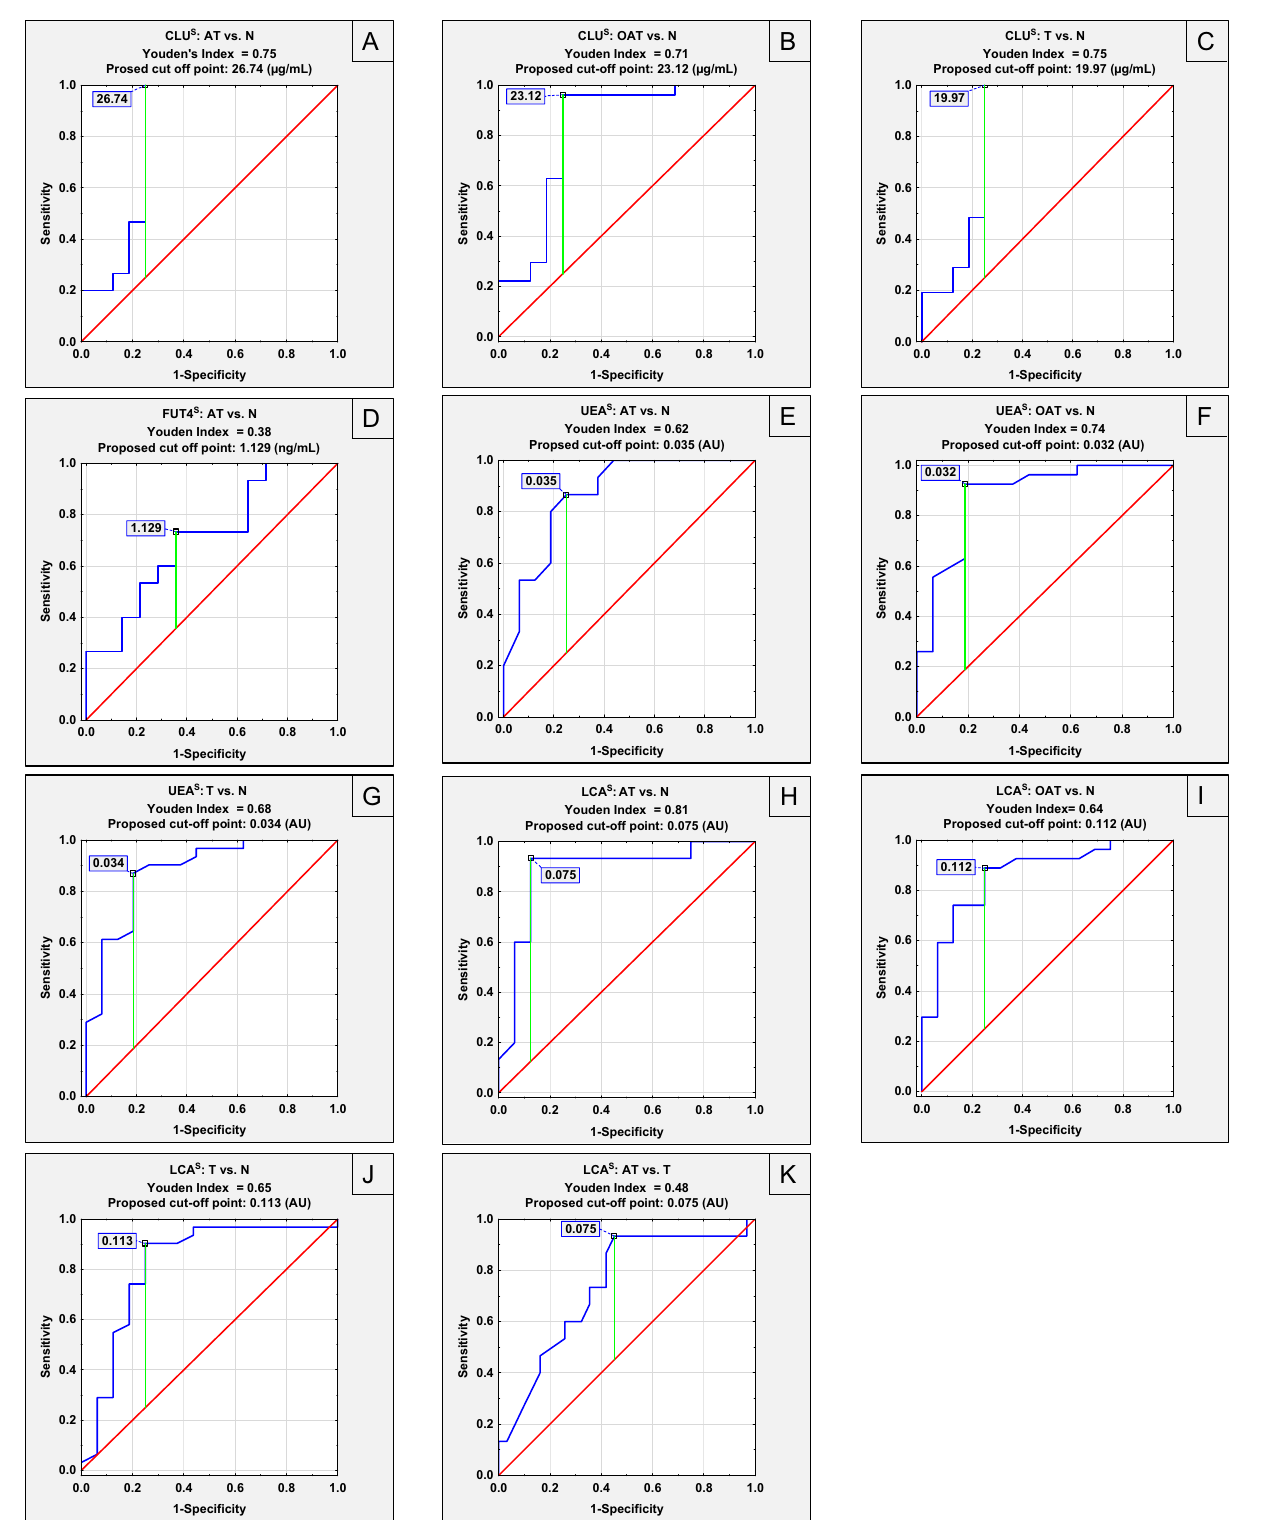
Figure 4. Receiver operating characteristic (ROC) curves for serum parameters with the area under the curve (AUC) more than 0.700 ( A–K ). CLU S —serum CLU concentration; FUT4 S —serum FUT4 concentration; UEA S - relative reactivity of serum CLU glycans with Ulex europaeus agglutinin; LCA S -relative reactivity of serum CLU glycans with Lens culinaris